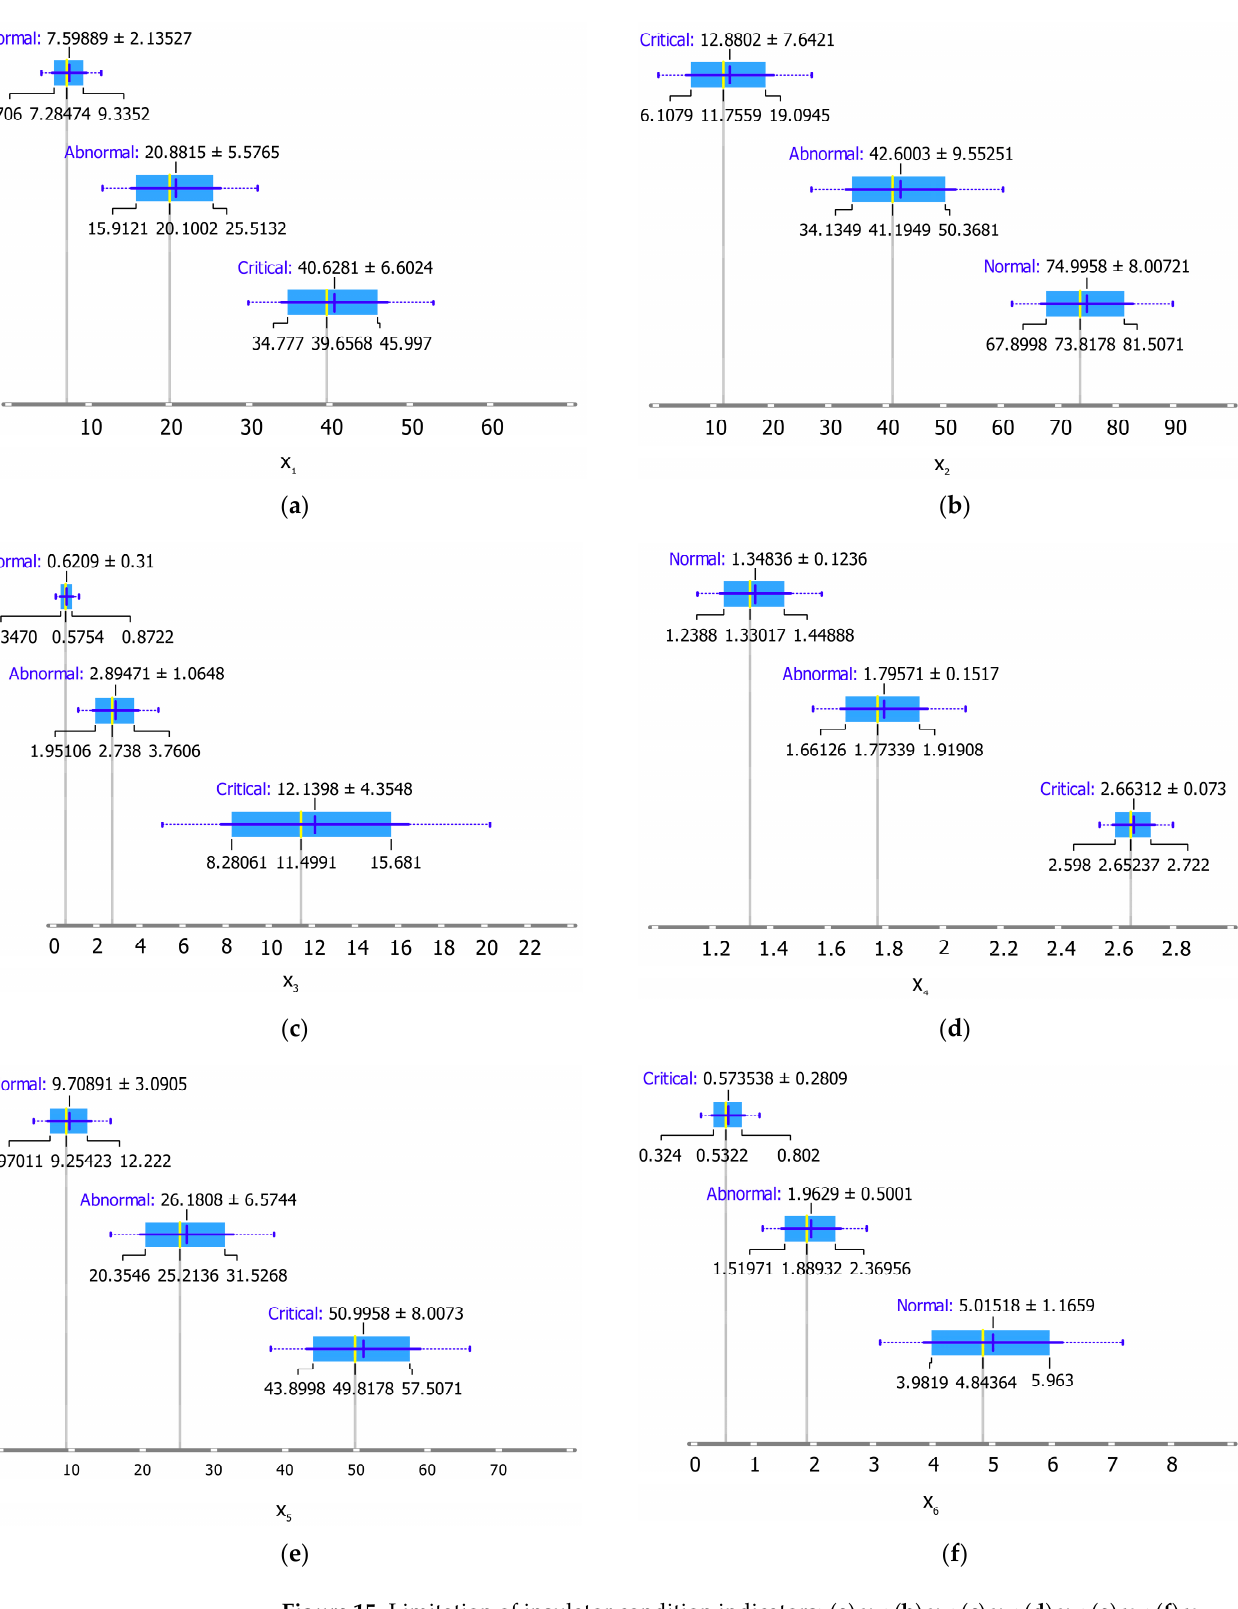
Figure 15. Limitation of insulator condition indicators: ( a ) x 1 ; ( b ) x 2 ; ( c ) x 3 ; ( d ) x 4 ; ( e ) x 5 ; ( f ) x 6 .